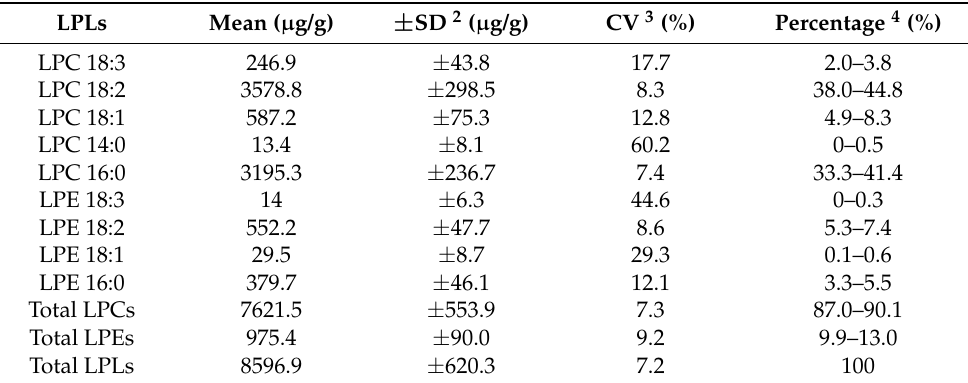
Table 1. Individual and total LPL concentration in freeze-dried wheat flour 1